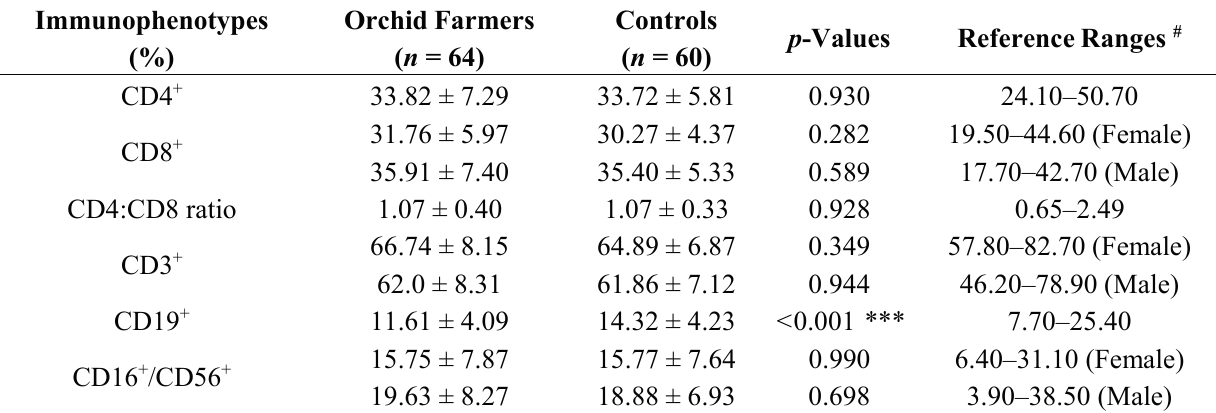
Table 5. Percentages of lymphocyte subpopulations in orchid farmers and in controls (Mean ± S.D.)